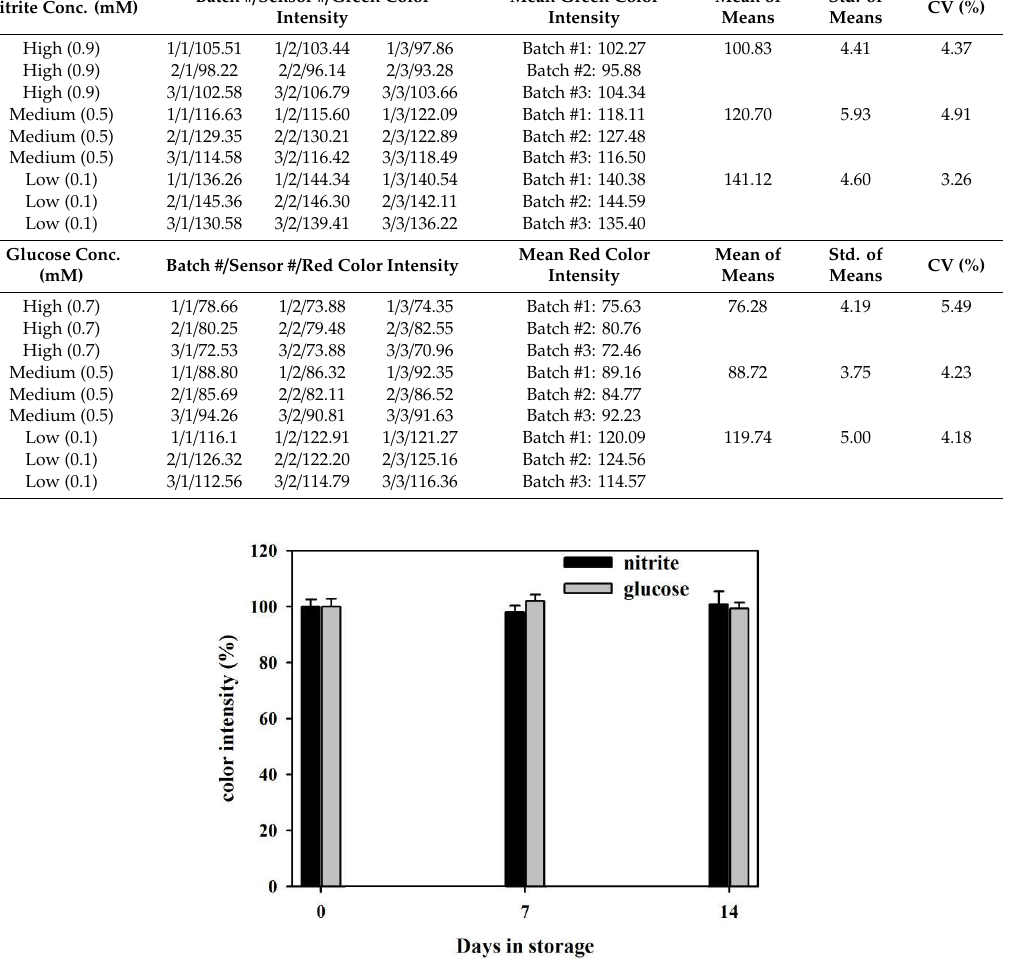
Figure 11. Storage stability of the developed µ PADs with immobilized reagents in the refrigerator (shown as % change with 100% being the response at day 0).